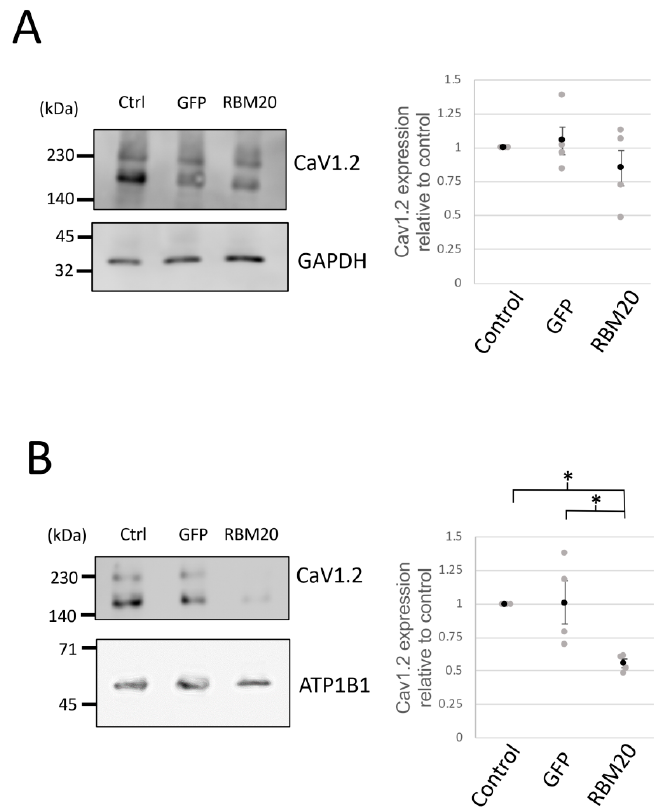
Figure 5. RBM20 modulates CaV1.2 membrane surface expression. ( A ) CaV1.2 protein expression levels were assesed by Western blot experiments. Pictures ( left ) of a whole-cell protein extract Western blot experiment showing CaV1.2 ( upper ) and GAPDH ( lower ) expression in control (ctrl), GFP, and RBM20-overexpressing cardiomyocytes. Graph ( right ) shows the ratio of the band intensity quantification from CaV1.2 over GADPH. Data are mean and SEM (black circle) from n = 4 di ff erent cardiomyocyte protein extracts (gray circle). ( B ) Cav1.2 membrane surface expression was assayed by membrane protein biotinylation followed by Western blot. Pictures show CaV1.2 ( upper ) and ATP1B1 ( lower ) expression. The graph shows the ratio of band intensity quantification from CaV1.2 over ATP1B1. Data are mean and SEM (black circle) from n = 4 di ff erent cardiomyocyte protein extracts (gray circle); * is p <